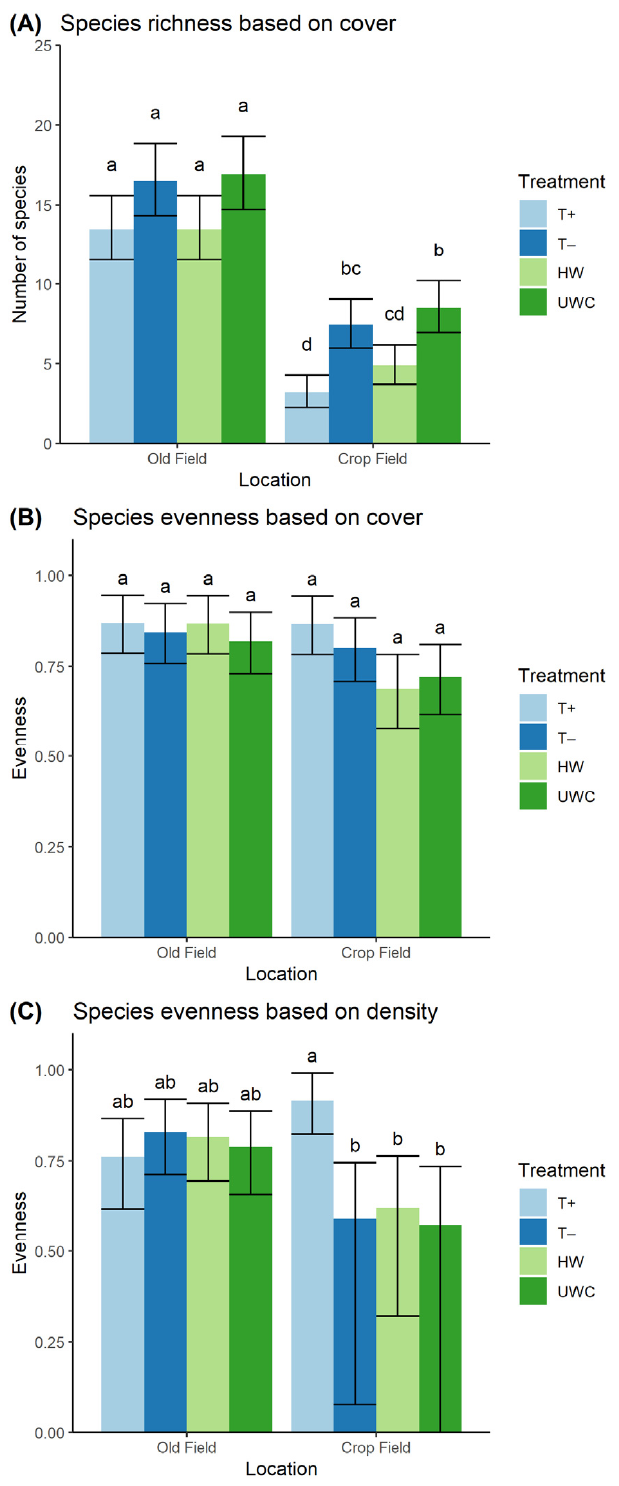
Figure 4. Effects of weeding treatment and location on species richness and evenness. ( A ) Total species richness per plot. ( B , C ) Evenness reflects whether weed species contribute equally to total weed cover (visual estimate) or density. This index ranges from 0 (complete dominance) to 1 (complete evenness). Bars marked with the same letter are not significantly different according to a Tukey test ( α = 0.05); 95% confidence intervals are shown. Abbreviations: T+—Tertill with trimmer; T − —Tertill without trimmer; HW—hand weeding by stirrup hoe; UWC—unweeded control. The old field had different dominant species than the crop field (Table 1). In the old field, only one of the four species seeded for this experiment (sorghum sudangrass) was among the five most dominant species. In the crop field, all four species were represented. The three most dominant species in the old field were monocots, whereas the three most dominant species in the crop field were dicots.